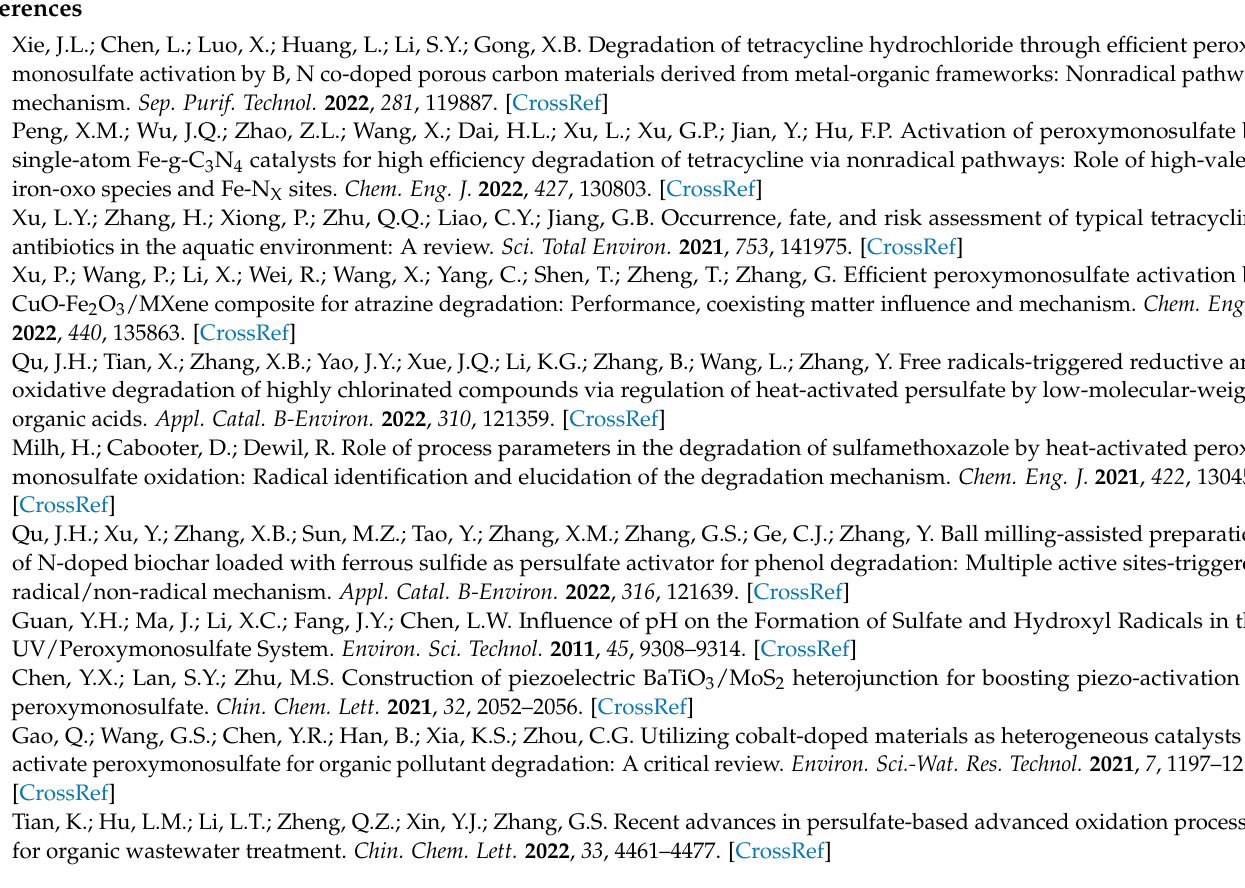
Figure S2: N 2 adsorption/desorption isotherms of CFO scratched from CFO-NF (insert: Barrett- Joyner-Halenda (BJH) analyzes); Figure S3: The standard curve of TC; Figure S4: The adsorption performance of CFO-NF towards TC; Table S1: Specific surface areas and pore characteristics of different catalysts; Table S2: The content of various elements in fresh and used